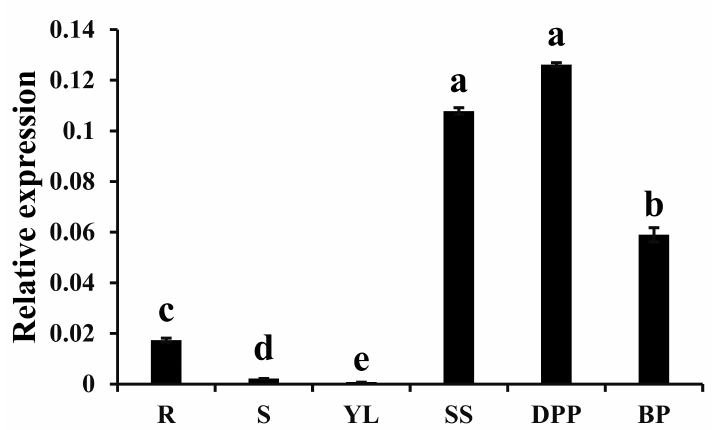
Figure 3. Expression profiles of CpWRKY75 in different tissues. R: Roots; S: Stems; YL: Young leaves; SS: sprout stage; DPP: display-petal period; BP: bloom period. Lowercase letters shown above the columns indicate significant differences (one-way ANOVA, Duncan’s multiple range test, p < 0.01).